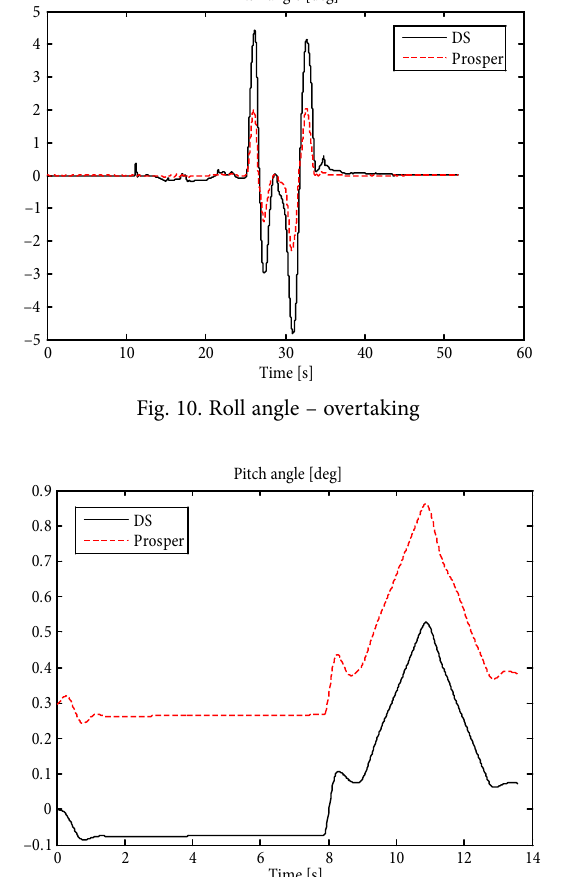
Fig. 11. Pitch angle – straight stretch